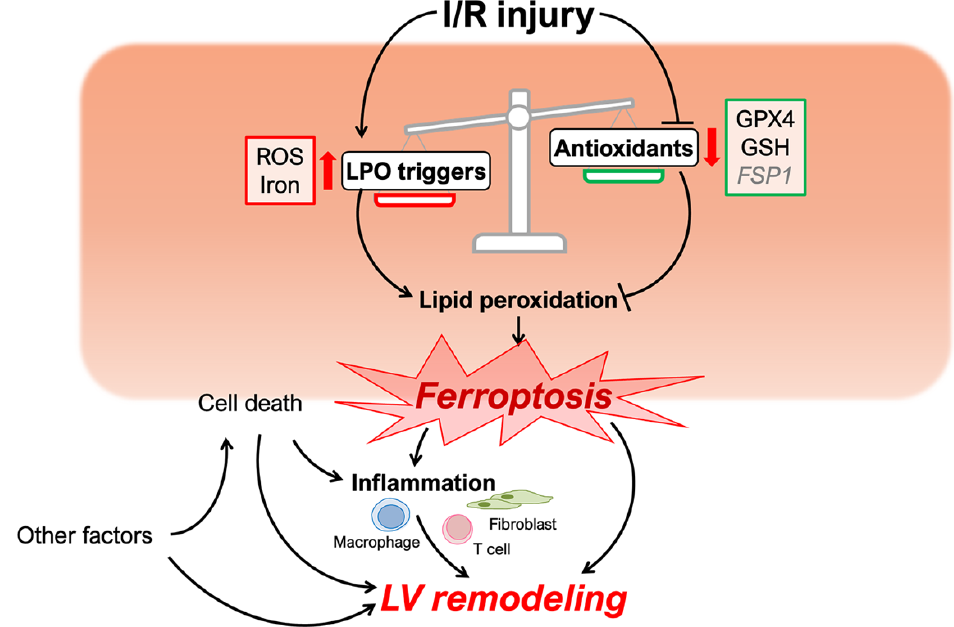
Figure 1. Schematic of ferroptosis and left ventricular remodeling caused by cardiac I/R injury. Cardiac I/R injury triggers the process of lipid peroxidation (LPO) and attenuates inhibitory mech- anisms preventing LPO. The disruption of redox homeostasis induces myocyte ferroptosis, which, with other factors, may influence left ventricular remodeling. ROS, reactive oxygen species; LOXs, lipoxygenases; GPX4, glutathione peroxidase 4; GSH, glutathione; FSP1, ferroptosis suppressor protein 1.